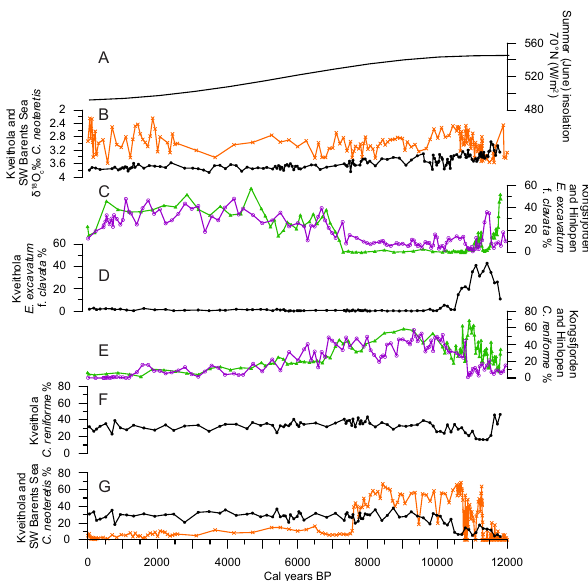
Fig. 6. Comparison of Holocene paleo-oceanographic develop- ment between Kveithola Trough, the SW Barents Sea (core PSh- 5159N) (Risebrobakken et al., 2010), Kongsfjorden (core NP05- 11-21GC) (Skirbekk et al., 2010) and Hinlopen Strait (core NP94- 51) (´Slubowska et al., 2005). For location of the selected cores see Fig. 1a. (A) June insolation at 70 ◦ N (Berger and Loutre, 1991). (B) δ 18 O c records from C. neoteretis for Kveithola (black, solid cir- cles) and the SW Barents Sea (orange, asterisks). (C) Percentages of E. excavatum f. clavata for Kongsfjorden (green, triangles) and Hinlopen (purple, open circles). (D) Percentages of E. excavatum f. clavata for Kveithola (black, solid circles). (E) Percentages of C. reniforme for Kongsfjorden (green, triangles) and Hinlopen (purple, open circles). (F) Percentages of C. reniforme for Kveithola (black, solid circles). (G) Percentages of C. neoteretis for Kveithola (black, solid circles) and the SW Barents Sea (orange,